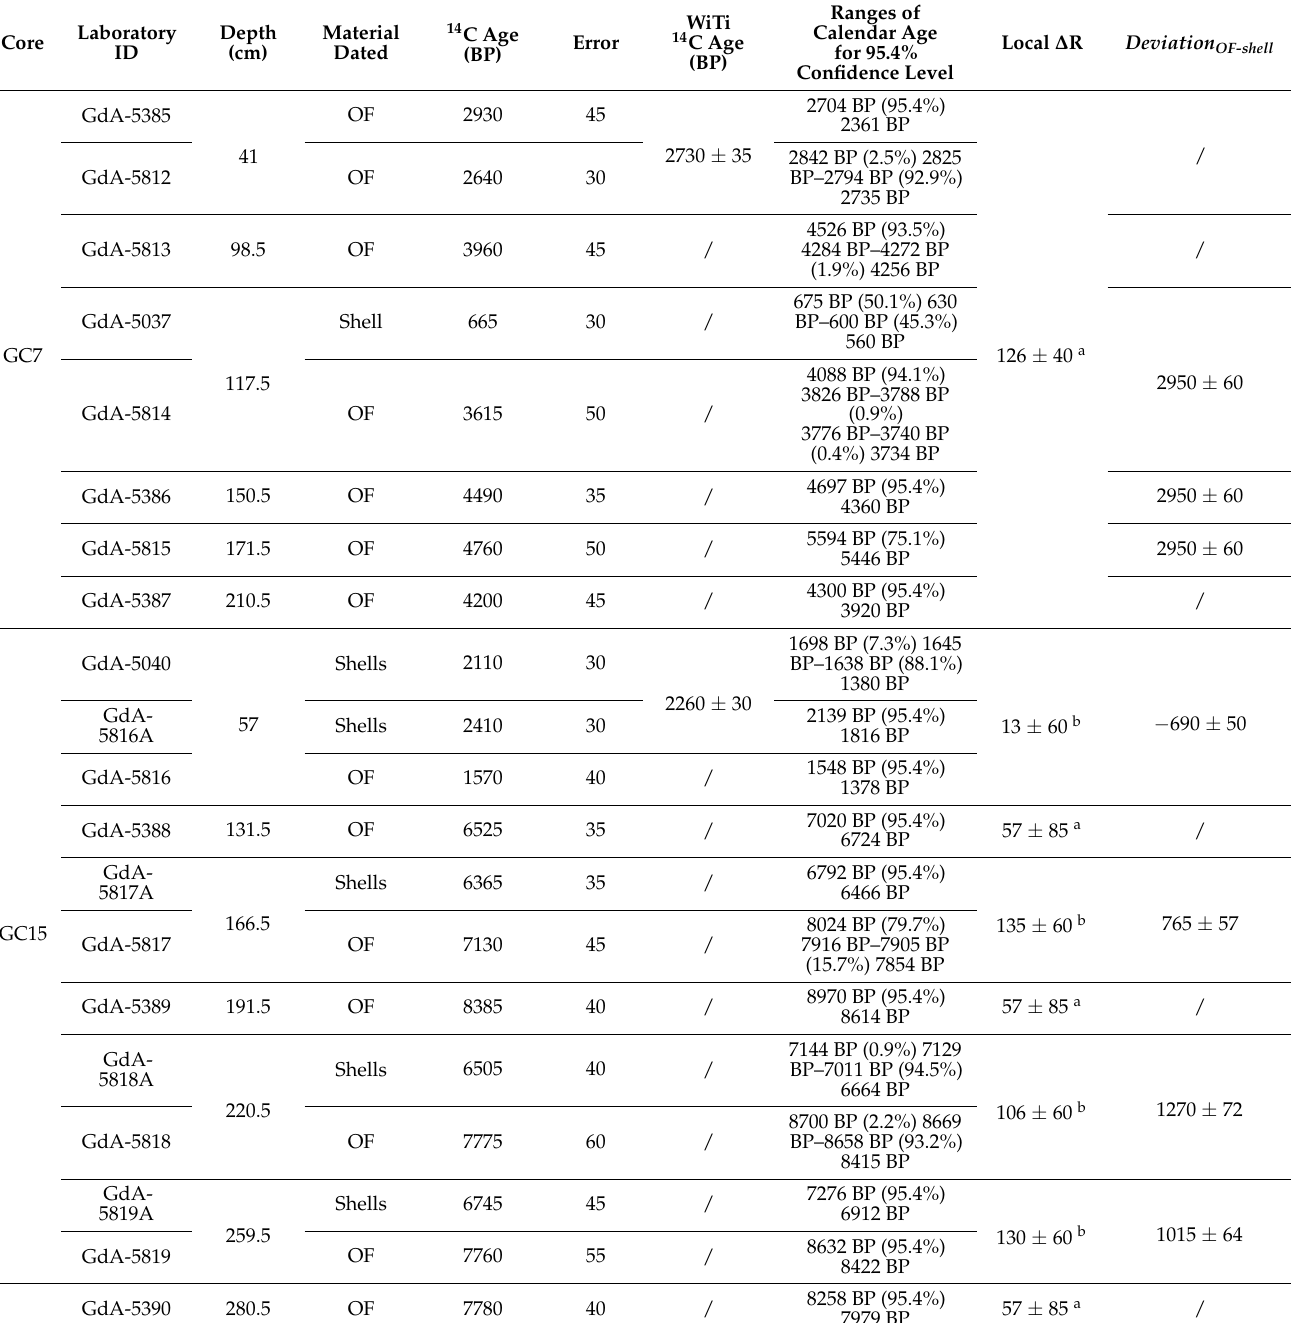
Table A2. Results of 14 C dating performed on GC7 and GC15 by the GADAM Centre (Silesian University of Technology, Poland). The dating conducted on the fine (<63 µ m) organic fraction of the sediment (OF) and on bivalve shells. The WiTi 14 C age corresponds to the weighted average of the 14 C age of two samples from the same depth. The Local ∆ R is the local reservoir effect correction estimated either from the Marine Reservoir Correction Database (http://calib.org/marine/, accessed on October 24, 2019), based on Siani et al. [32] and Jones et al. [33] or from δ 13 C measurements conducted on bivalve shells from GC15. The Deviation OF-shell is the shift between the 14 C shell age and the 14 C OF